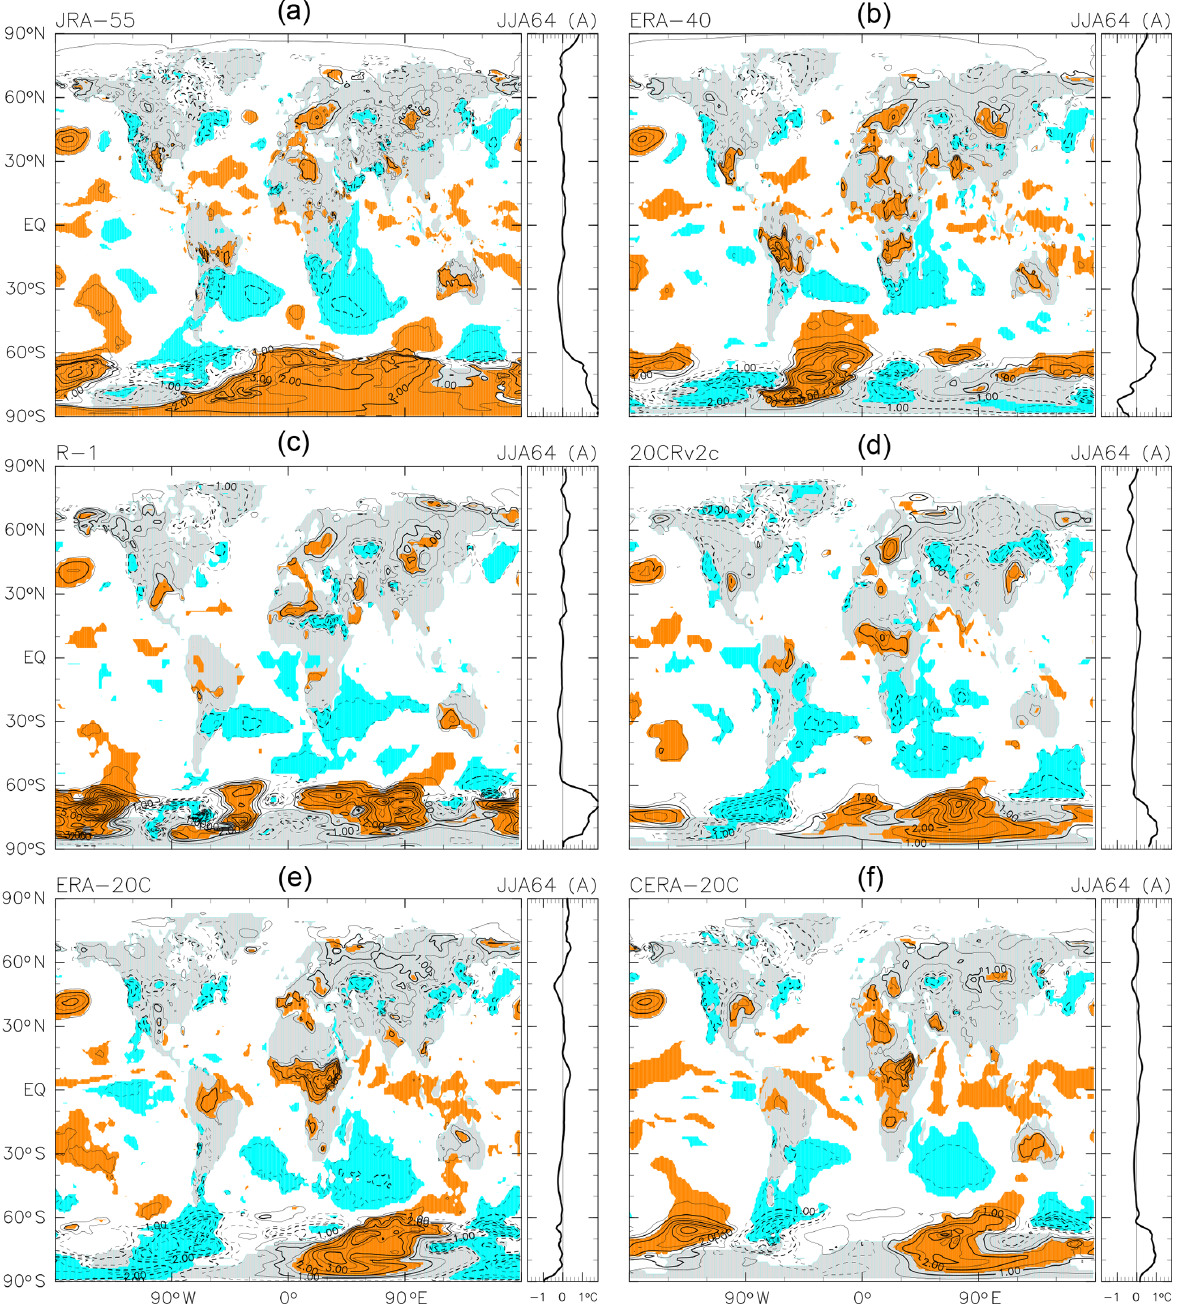
Figure 8. As for Fig. 7, but for the anomalies averaged over June to August 1964 following the Mount Agung eruption in March 1963. The contour interval is 0.5K, without 0.0K lines. Coloured shading denotes anomalies that are positive (orange) or negative (blue) with magnitudes exceeding 1 SD of the 3-month mean R(t) at that